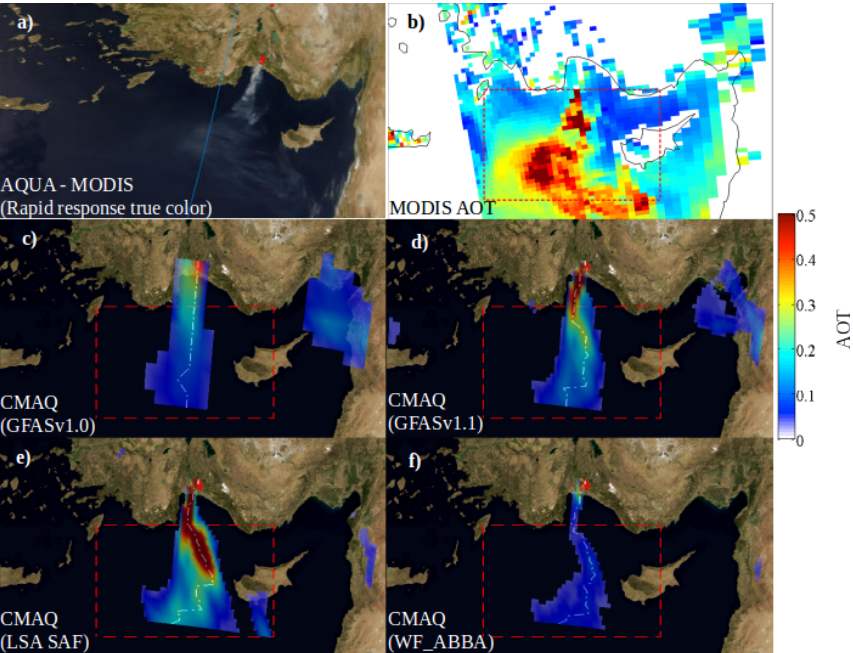
Figure 6. (a) MODIS (true color composite from visible wavelengths) over the eastern Mediterranean basin on 1 August 2008 at 14:30LT. (b) Concurrent MODIS level 2 aerosol optical thickness. Concurrent CMAQ-simulated changes in AOT due to fires made by using GFAS1.0 (c) , GFAS1.1 (d) , LSA SAF-based (e) and WF_ABBA-based (f) fire emission inventories. The changes in the AOT are calcu- lated by subtracting concentrations from simulations without fires. The white-dashed line connects the cells of the model grid having the maximum-simulated AOT along the Antalya fire plume. MODIS AOT color scale is the same as the one for the simulated changes in AOT.